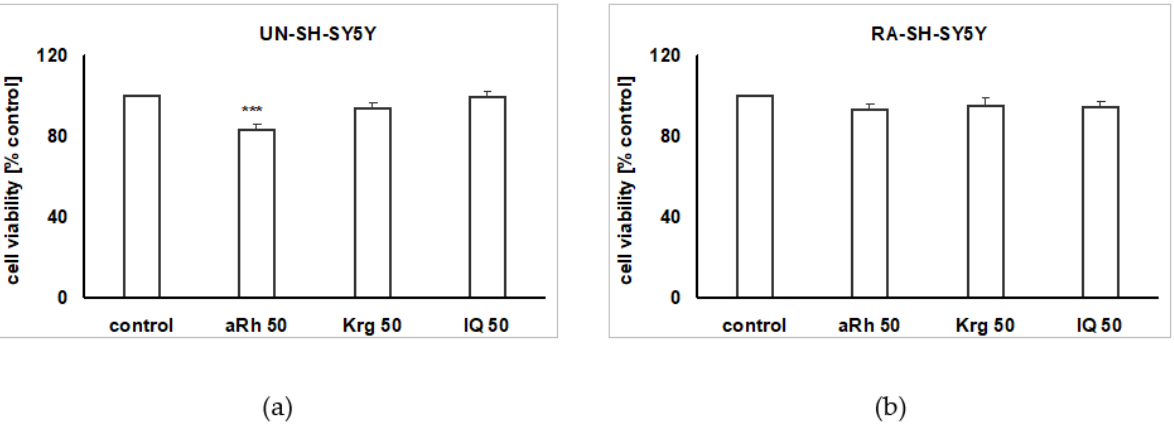
Figure 3. Biosafety assessment of α -rhamnoisorobin (aRh), kaempferitrin (Krg), and isoquercitrin (IQ) in: ( a ) undifferentiated (UN-) and ( b ) retinoic acid-differentiated (RA-) SH-SY5Y cells. The cells were treated either with vehicles or with aRh (50 µ M), Krg (50 µ M) and IQ (50 µ M) for 24 h. Statistical analysis was done with one-way ANOVA. Cell viability was measured with WST-1 assay and the data were normalized to vehicle-treated cells and presented as the mean ± SEM from 4–5 independent experiments with three repetitions. *** p < 0.001 vs. vehicle-treated cells.